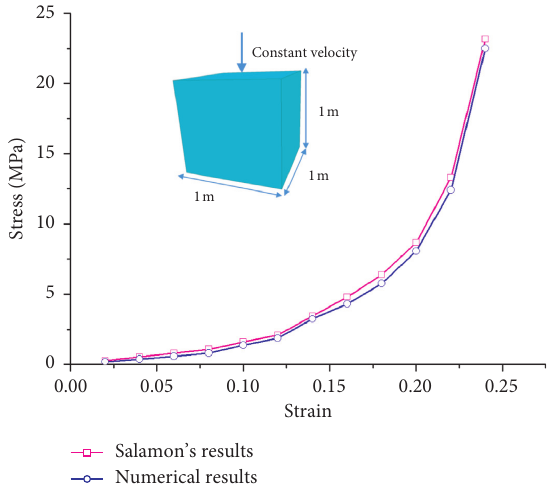
Figure 10: Stress-strain in the double yield model.